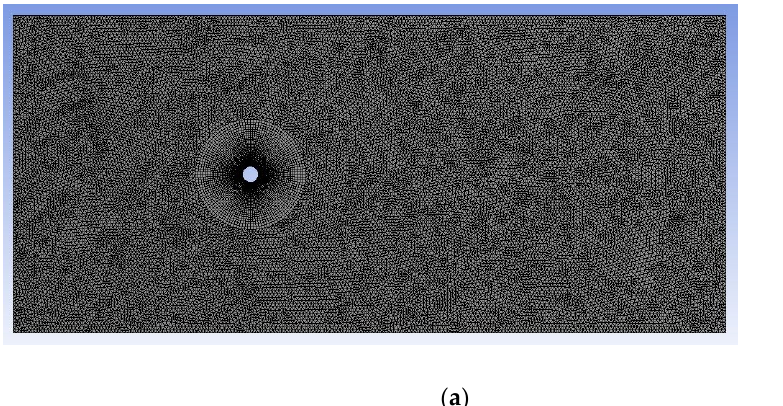
Figure 1. Computational domain.